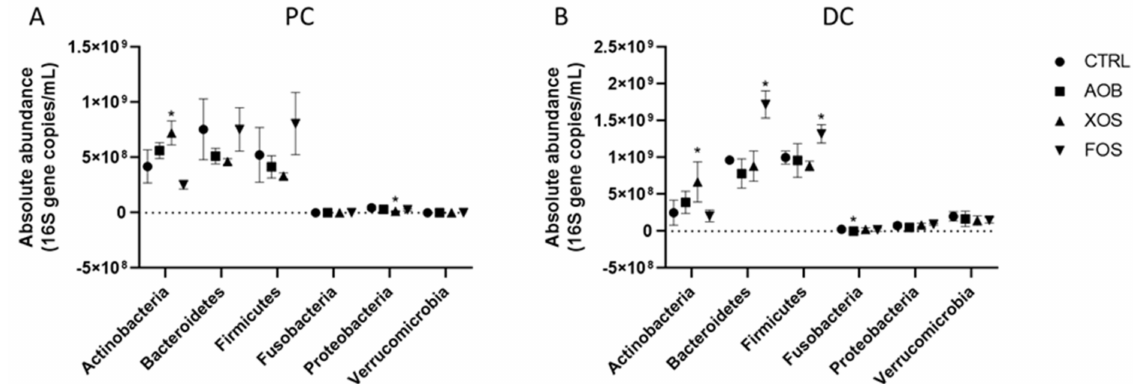
Figure 6. Effect of AOB, XOS and FOS on microbial community composition of donor 2 at phylum level during 2 weeks of treatment versus the control for PC ( A ) and DC ( B ). Average of 4 time points (day 3/4/10/11) as absolute abundance (16 S gene copies/mL)of the different phyla for the two colon regions (PC and DC). PC = proximal colon; DC = distal colon; CTRL = control; AOB = antioxidant blend; XOS = xylooligosaccharides; FOS =